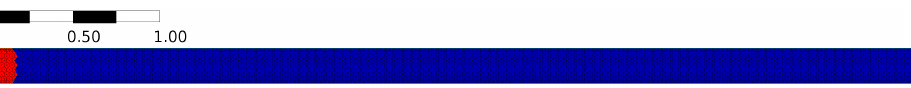
Figure 1. Plan view on the initial situation of the lock exchange experiments carried out by Gladstone et al. [19] on a hexahedral mesh with 3cm cell diameter; red: c = 3490ppm, blue: c =